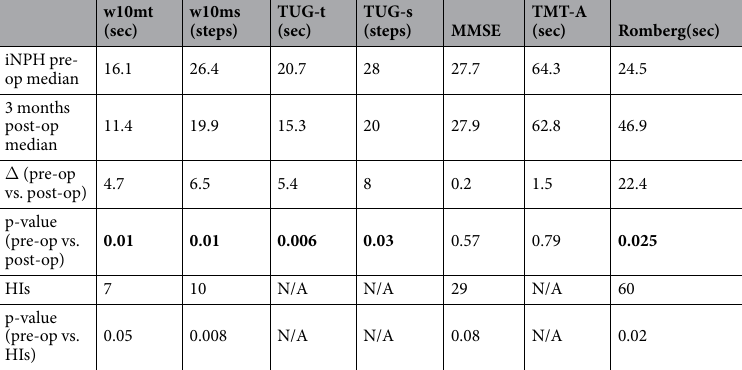
Difference post- op vs. pre-op